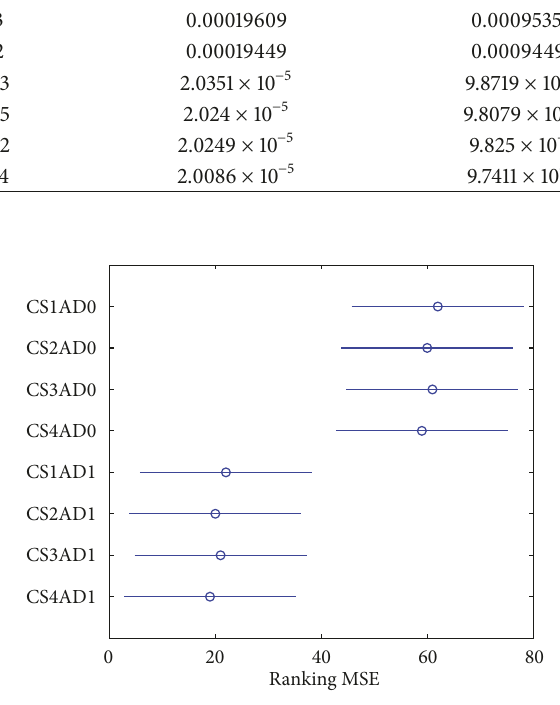
Figure 17: Multiple comparisons